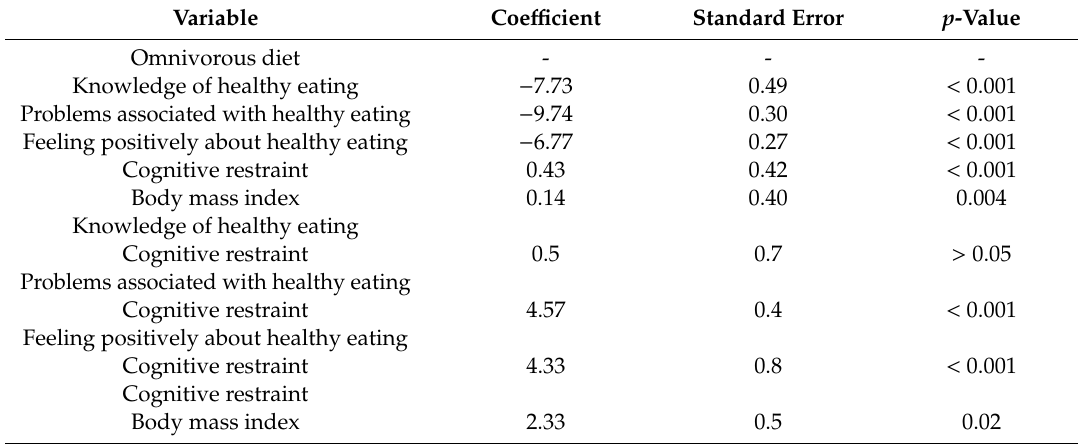
Table 4. Coe ffi cient, standard error and p -value of the structured equation modeling (SEM) Table 4. Coefficient, standard error and p -value of the structured equation modeling (SEM) Table 4. Coefficient, standard error and p -value of the structured equation modeling (SEM) approach approach model. approach model. Table 4. Coefficient, standard error and p -value of the structured equation modeling (SEM) Table 4. Coefficient, standard error and p -value of the structured equation modeling (SEM) approach model. approach model.